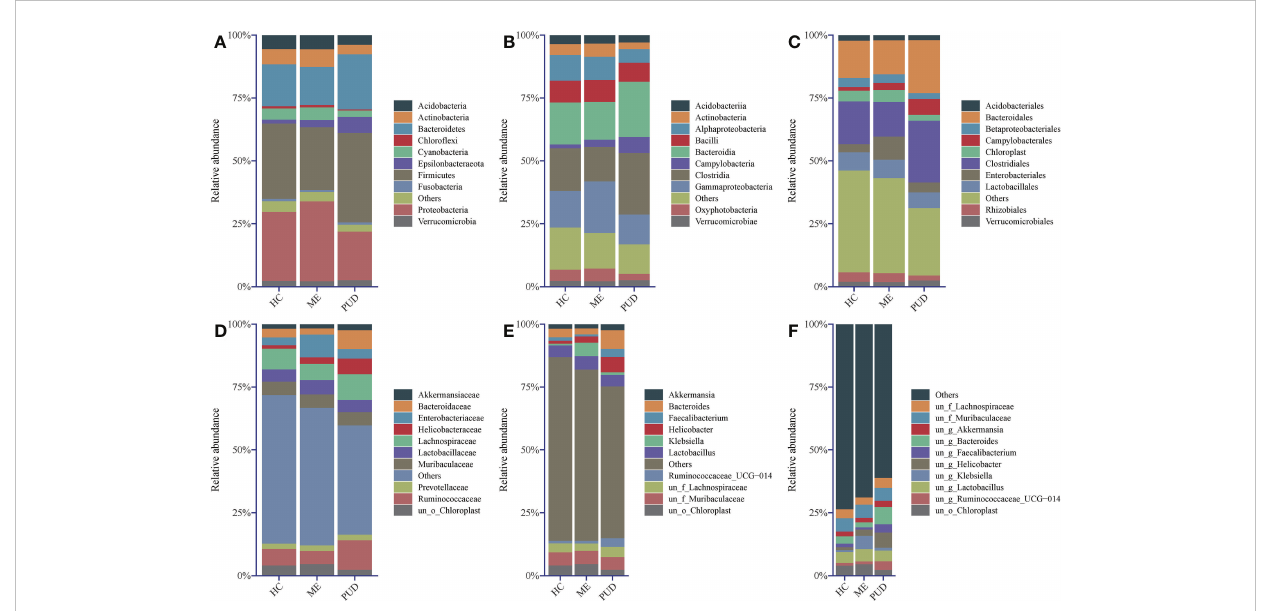
FIGURE 2 Abundance structure of top 10 fl ora. (A) , phylum level; (B) , class level; (C) , order level; (D) , family level; (E) , genus level; (F) , species level; un, unidenti fi ed; o, order; f, family; g, genus; others, sum of abundance of other fl ora.